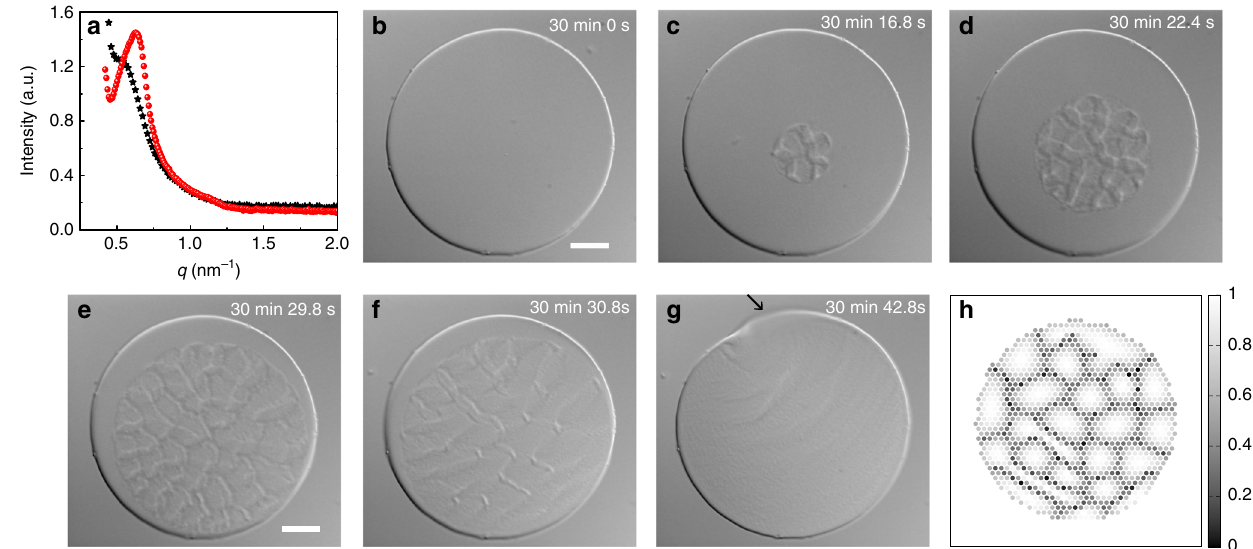
Fig. 2 Curvature instability during fl uid – crystal transition in colloidal membranes. a SAXS intensity as a function of scattering wave vector ( q ) for fl uid (black stars) and crystalline (red circles) colloidal membranes at 20 and 25 mg ml − 1 PEG concentration, respectively. b – d Time lapse sequence of nucleation and growth of a crystalline domain within a fl uid membrane. The growing domain spontaneously develops a network of local ridges (protrusions). Scale bar, 10 μ m. e – g Time-lapse sequence showing annealing of the ridges, shown in b – d , as the growing domain encounters the edge. The black arrow in the last panel highlights the out of focus edge of the transformed membrane. Scale bar, 10 μ m. h Grain boundary formation as obtained in the discrete MC simulation using Eq. (1). The plot in grayscale shows the z -component of the directors, i.e., ^ n i ð Þ z 2 ½ 0 ; 1